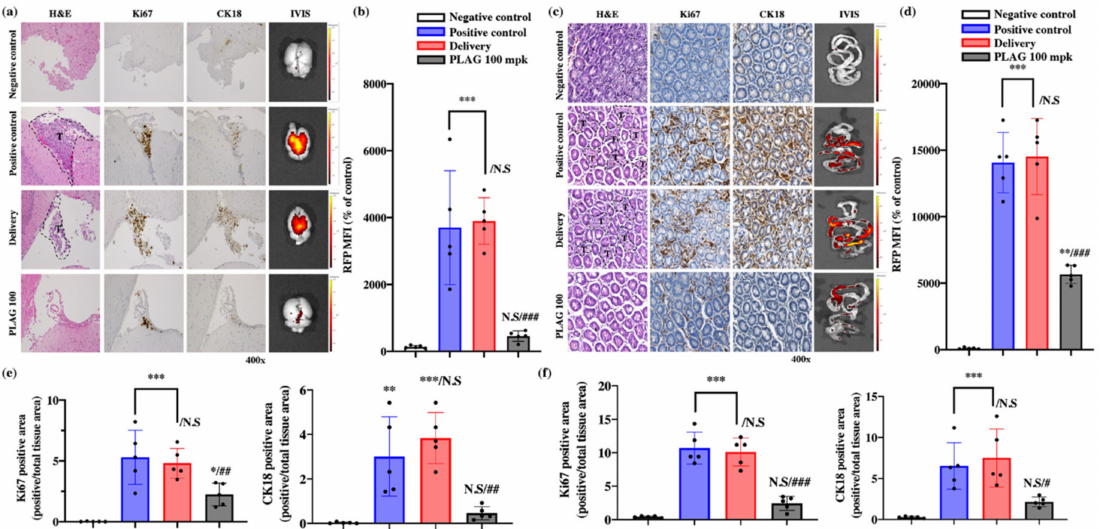
Figure 2. Inhibitory e ff ects of PLAG on tumor metastasis: ( a ) Inhibition of tumor metastasis into the brain in PLAG-treated mice was verified by immunohistochemical staining with anti-Ki67 and anti-CK18 antibodies; ( b ) The RFP-positive MFI value in the brain regions of each group.